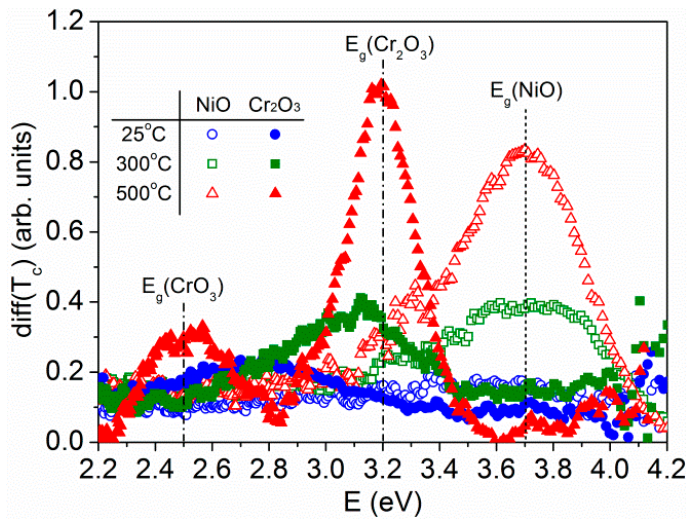
Figure 5. Determination of the optical gap energy for the various NiO and Cr 2 O 3 layers from the first derivative of the respective transmittance spectrum in Figure 4.